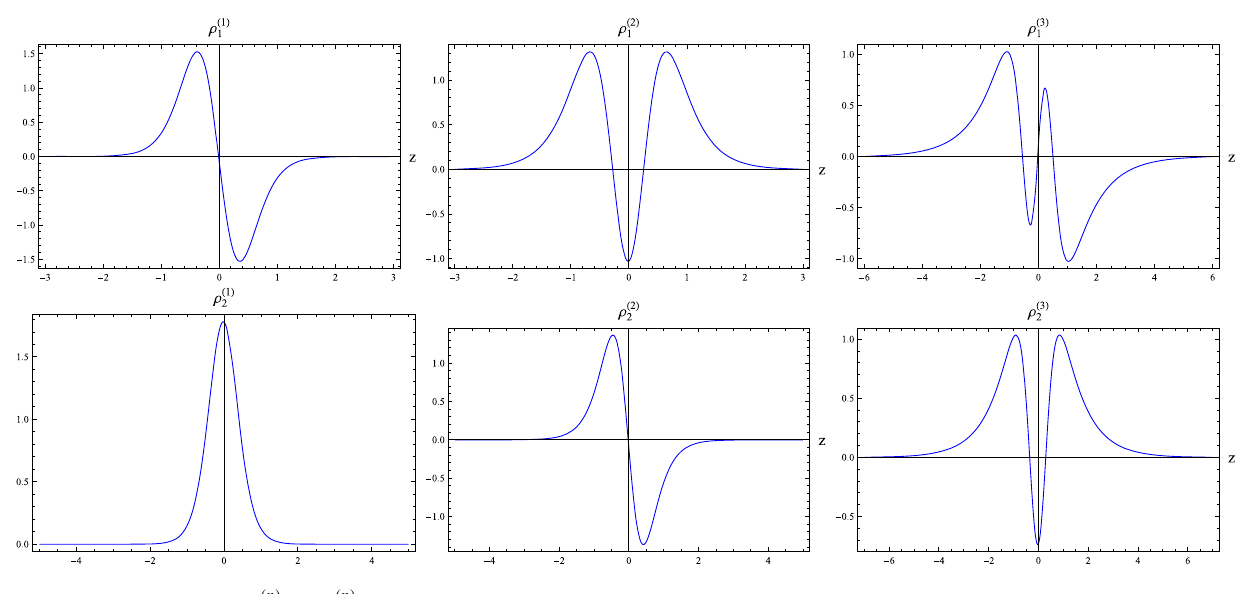
Fig. 2 The wave functions ρ ( n )